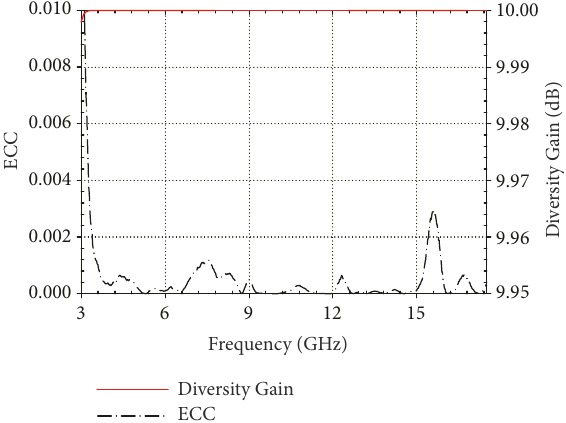
Figure 8: Measured ECC and DG of the proposed antenna.